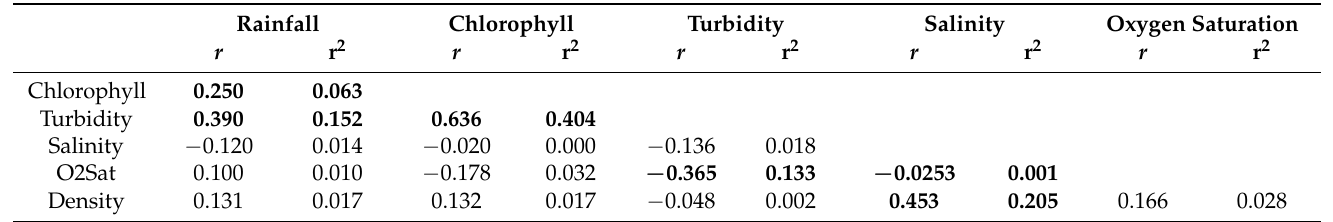
Table 1. Pearson’s correlation efficient analysis. Significant values ( p < 0.05) are displayed in bold. N = 63.